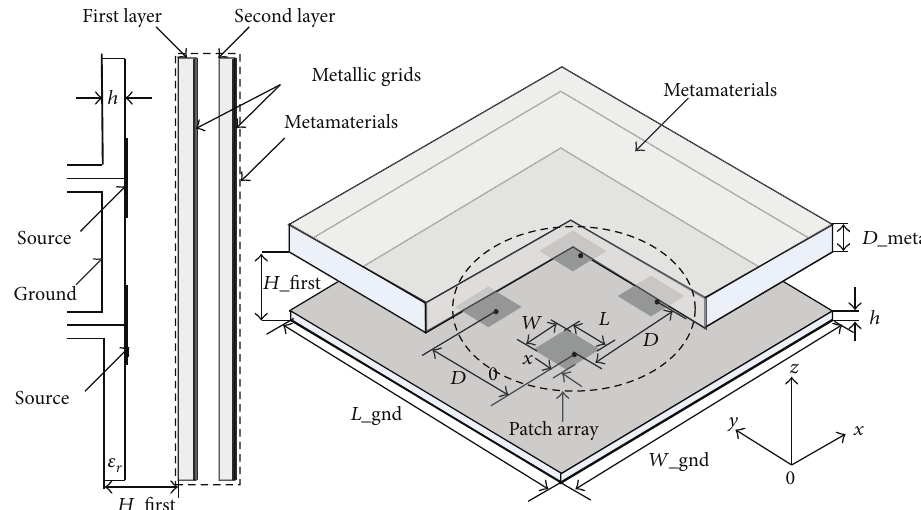
Figure 1: 2 × 2 element antenna array integrated with MTMs-cover.